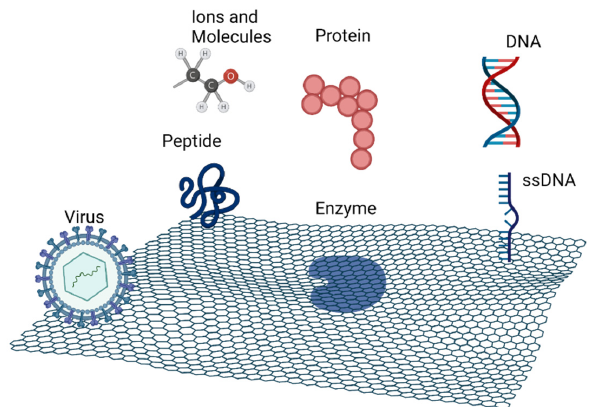
Figure 1. Schematic representation of the main biomolecular systems that can interact with graphene. Figure created with BioRender.com (accessed on 28 February 2022).